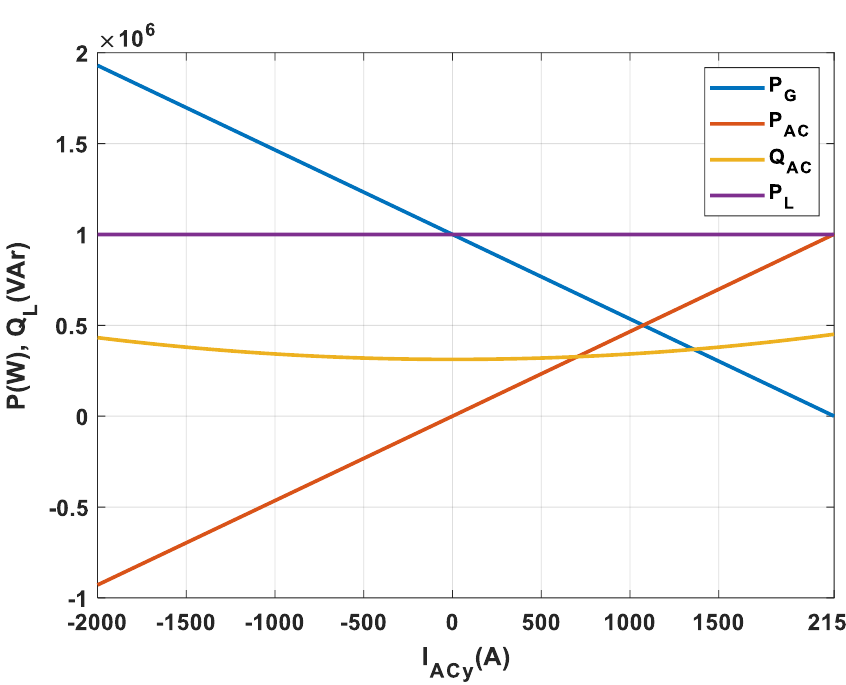
Figure 7. Energy characteristics of the network energy consumption optimization system.